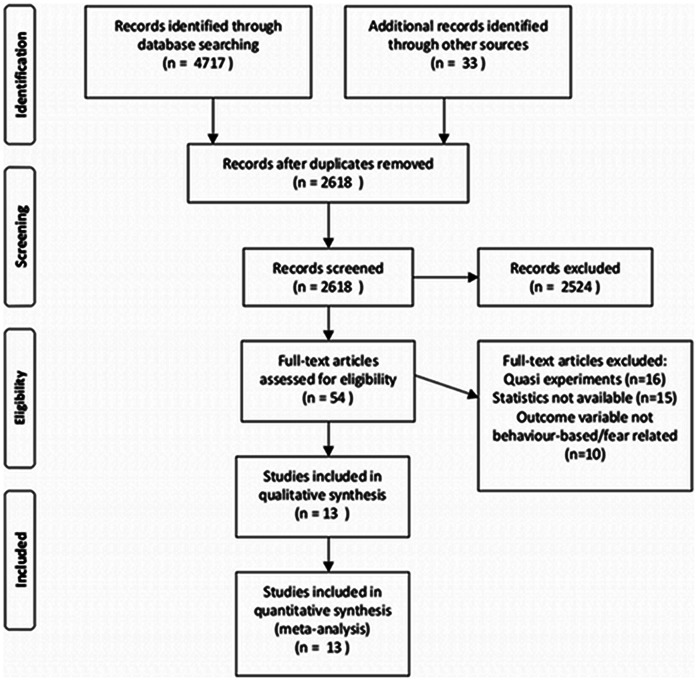
PRISMA Flow Diagram outlining identification and selection procedures.